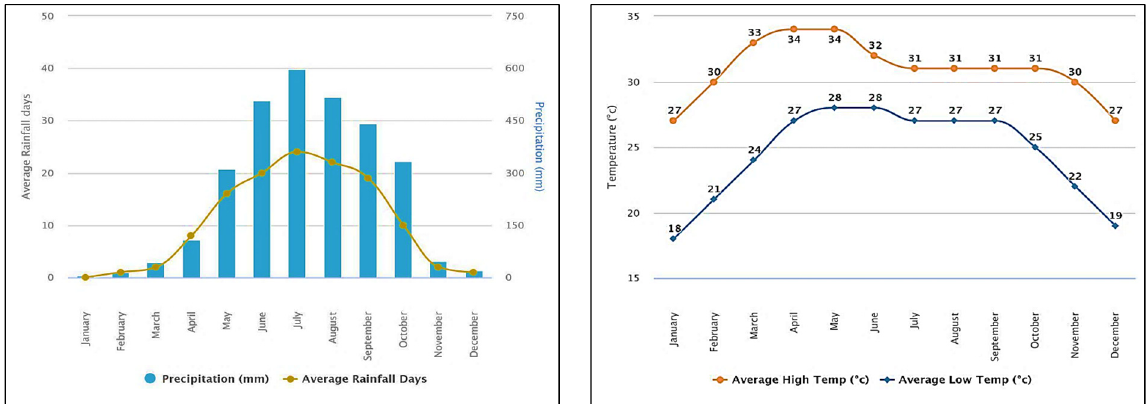
Figure 1. Average rainfall, maximum and minimum temperature during crop growth stage.